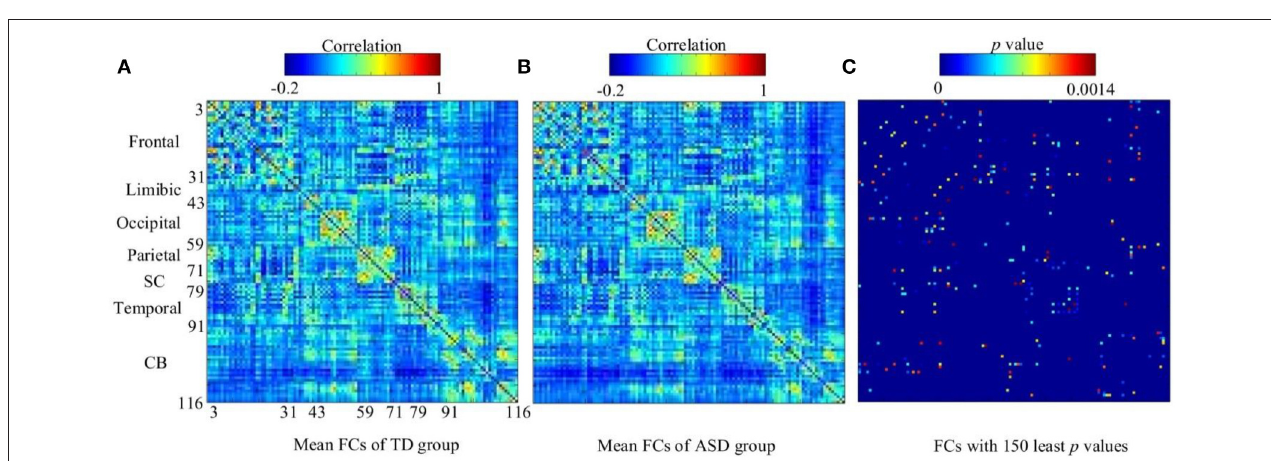
FIGURE 7 | The mean Fisher’s score and its SD (mean/ SD ) for each hidden layer from the DNN-FS and the DNN-woFS. (A) The first hidden layer. (B) The second hidden layer. (C) The third hidden layer.